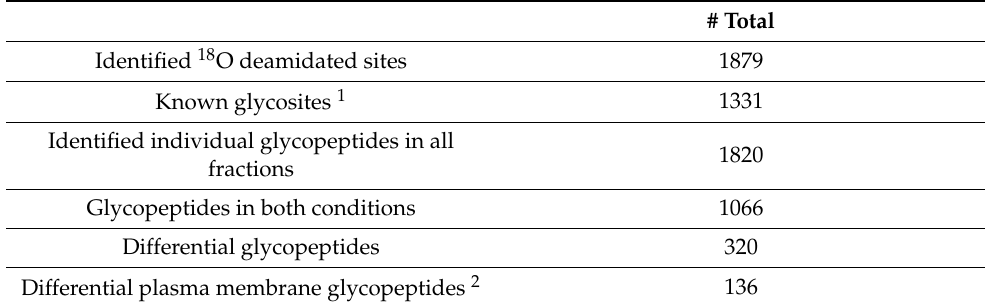
Table 1. Summary of differential glycosite profiling of 2DG vs. untreated control